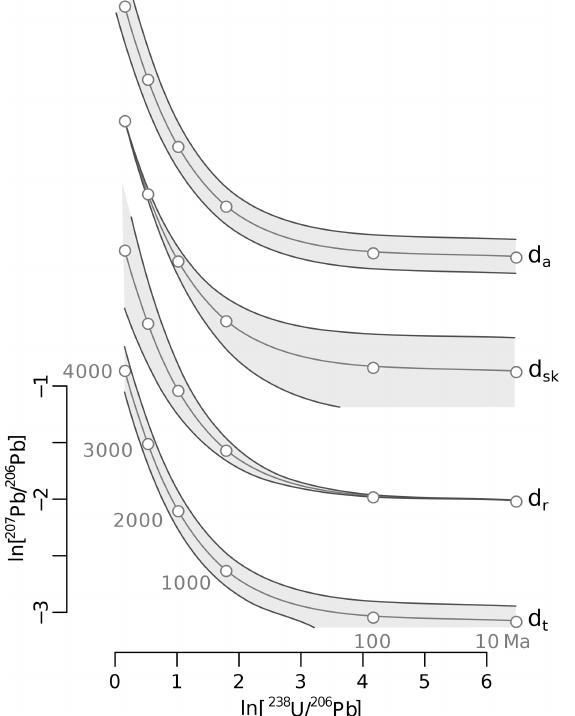
Figure 3. Discordance cutoffs for four of the six discordance def- initions discussed in Sects. 3 and 4. The d p and d c criteria are not shown because they depend on the analytical uncertainty of the measurements, which may vary between studies. The grey envelopes mark cutoff values of d r = 20% (relative age filter), d t = 300Myr (absolute age filter), d sk = 2% (Stacey–Kramers fil- ter), and d a = 15% (perpendicular Aitchison distance) on a Tera– Wasserburg concordia diagram, which is plotted in logarithmic space to provide a more balanced view of the old and young ends of the timescale. The d sk and d t envelopes are truncated where they cross over into physically impossible negative isotope ratio space.